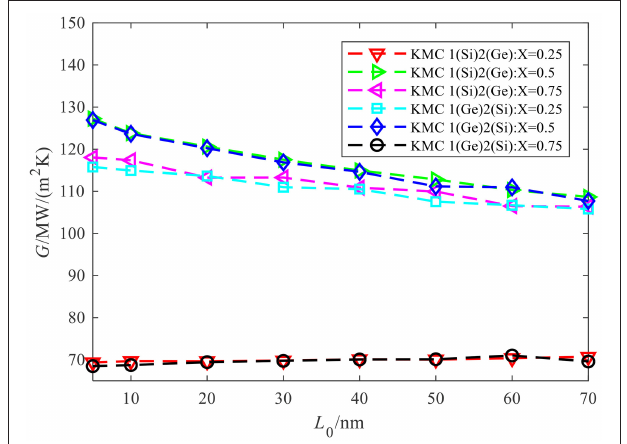
FIGURE 6 | The temperature distribution of four-layer thin film with 1(Si) and 2(Ge) collocation and L 0 equal to 70 nm: blue squares are results for the present Monte Carlo simulation and magenta lines are fitting lines for results of Monte Carlo simulation. The non-dimensional position coordinates for the three interface temperature jumps are as 0.25, 0.5, and 0.75, respectively.